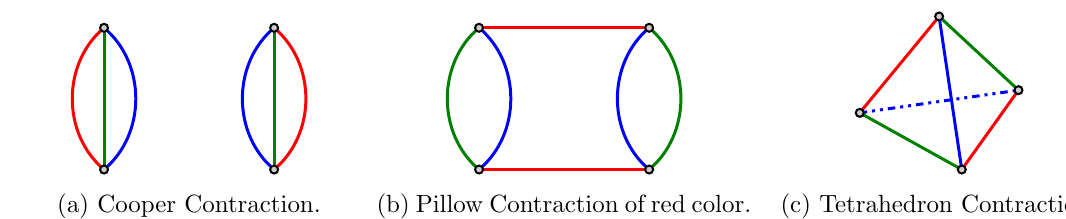
Figure 1. Cooper, Pillow and Tetrahedron contractions. Each vertex represents a fermion, and the colored edge denotes the contraction of gauge index of the corresponding color in the two